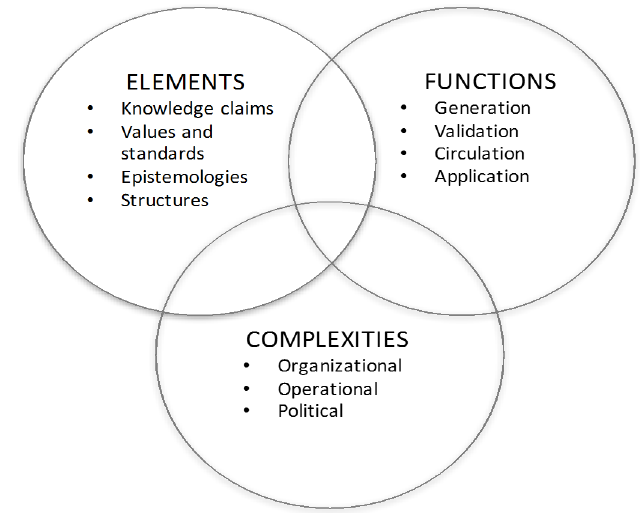
Figure 2. Main components of the knowledge systems analysis